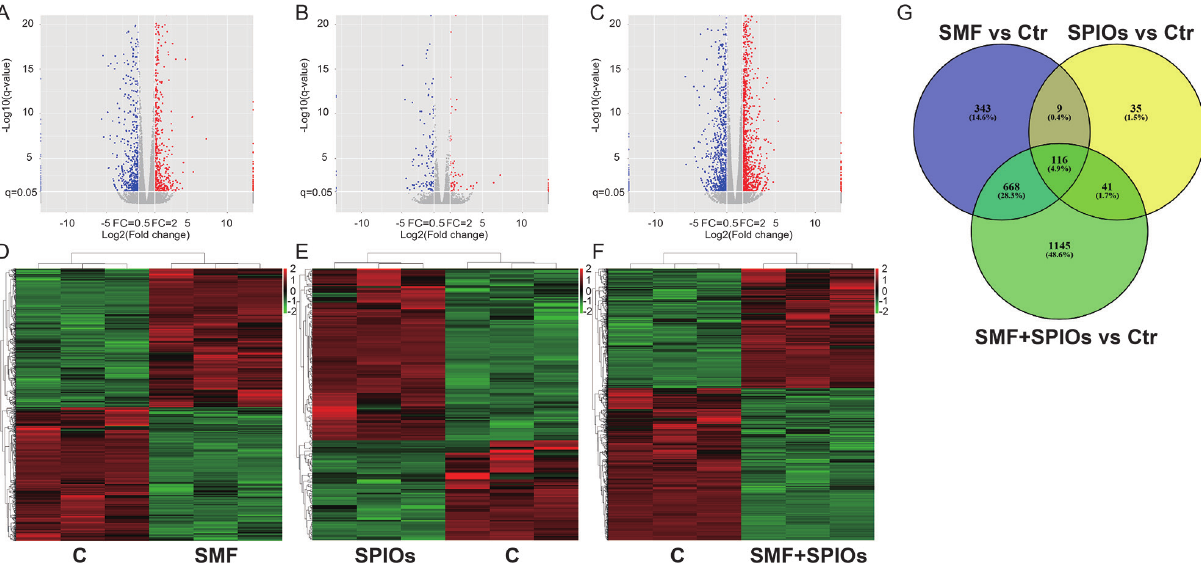
Fig. 1. Differentially expressed gene analysis. Volcano plots of different expressed genes of SMF versus control group (A), SPIOs versus control group (B), the SMF + SPIOs versus control group (C). Red dots represent the differentially expressed genes of the up-regulated expression, the blue dots represent the differentially expressed genes of the down-regulated expression, and the gray dots represent the genes that have no obvious differential expression. Heat map to differentially expressed gene of the SMF versus control group (D), SPIOs versus control group (E), the SMF + SPIOs versus control group (F). (G) Venn diagram of differentially expressed gene in different